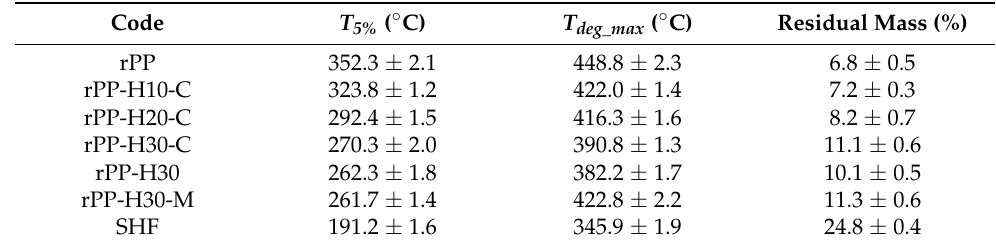
Figure 4. Comparative plots of ( a ) thermogravimetric curves and ( b ) DGT curves of the rPP/hemp fiber composites with different compatibilizers. Table 4. Main thermal parameters obtained by TGA of the rPP/short hemp fiber composites with different